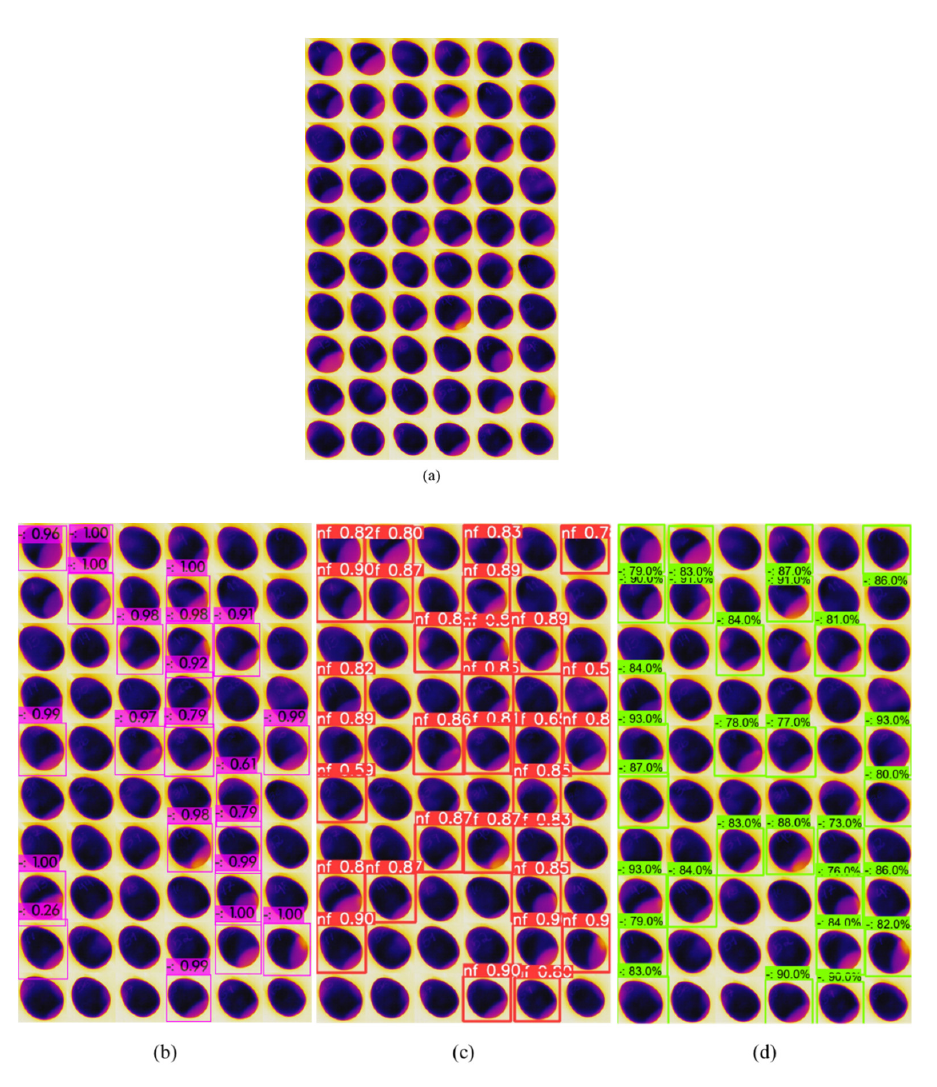
Figure 16. ( a ) The original images of 60 eggs were used to test the deep learning object detection models. ( b – d ) YOLOv4, YOLOv5, and EfficientDet models applied to the original testing dataset.